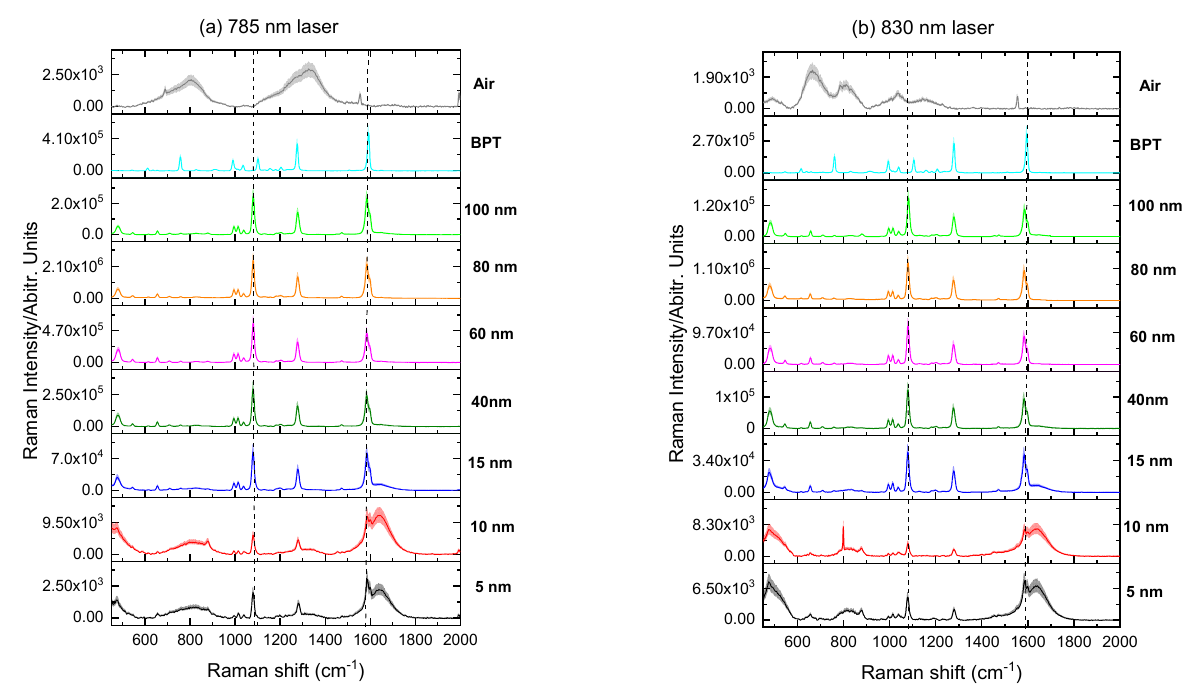
Figure 8. Raman spectra of BPT labeled AuNP solutions measured at ( a ) 785 nm and ( b ) 830 nm. Dashed lines denote the two most prominent signals of BPT at 1080 and 1586 cm − 1 . Shading: standard deviation.